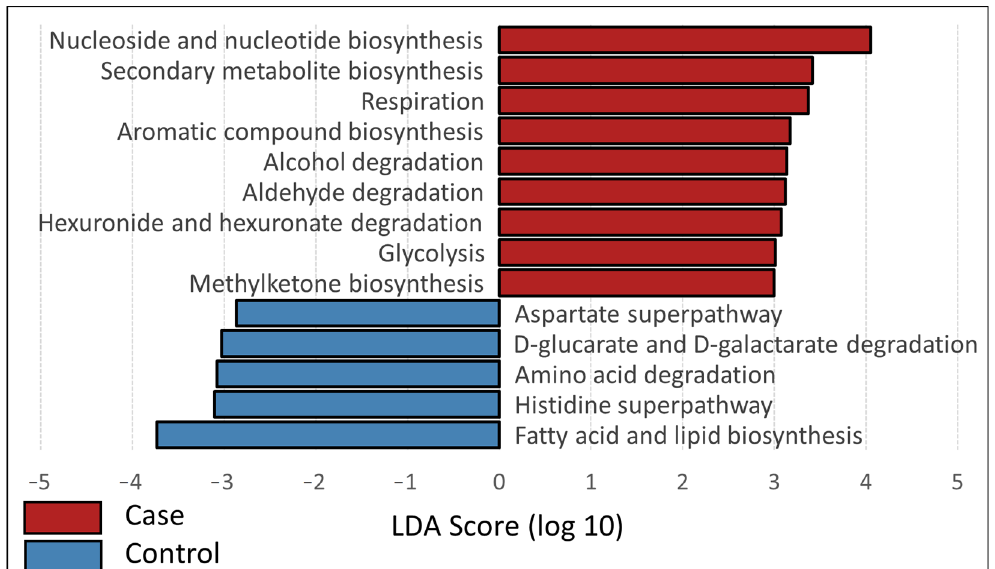
Figure 6. LEfSe analysis displaying differentially abundant second-level MetaCyc pathways between cases and controls, based on a linear discriminant analysis with p < 0.05 for Kruskal–Wallis tests.